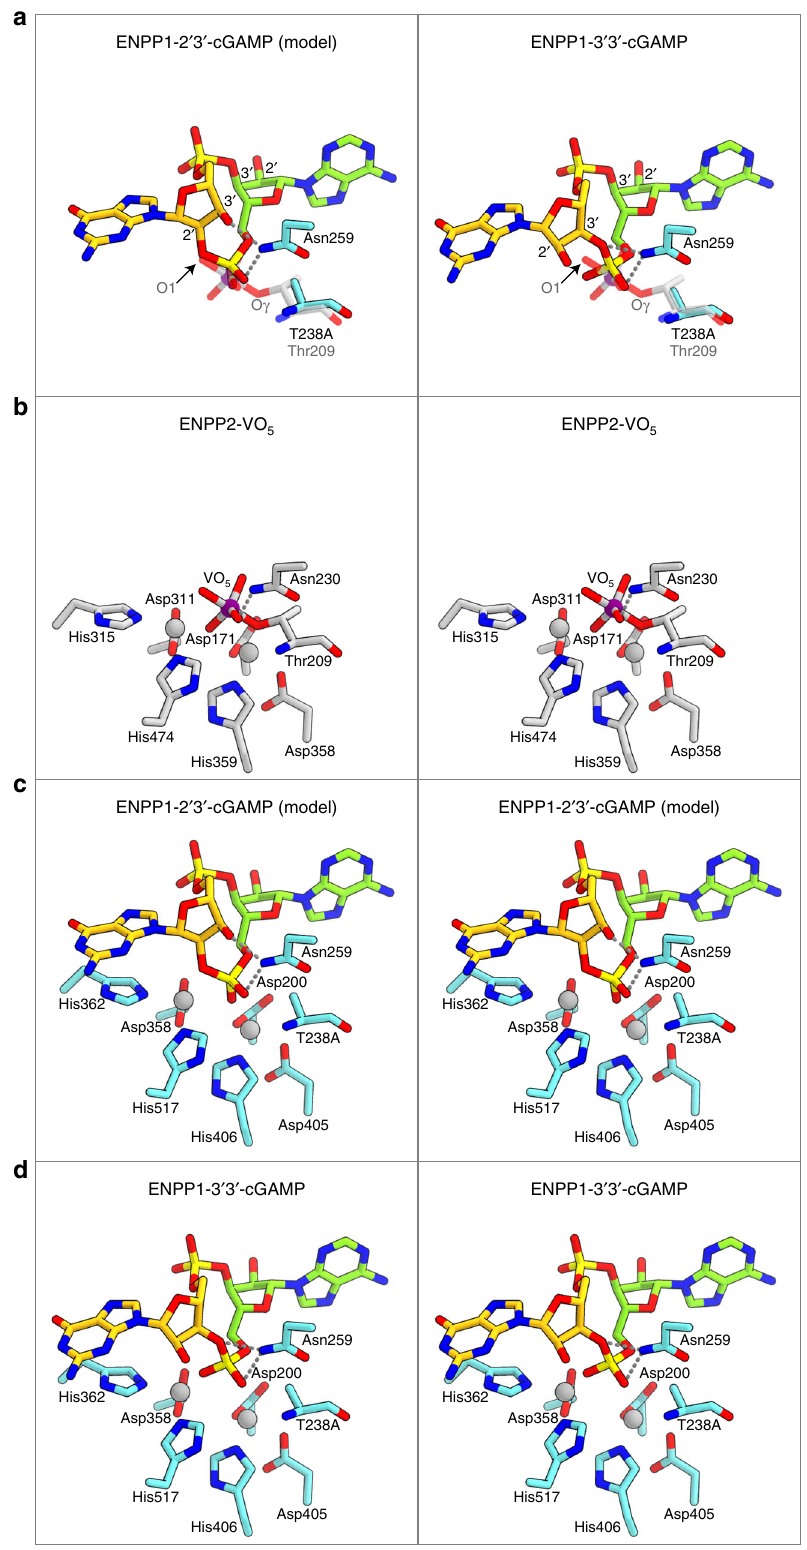
Fig. 4 Structural comparison between the ENPP1-bound 2 ′ 3 ′ -cGAMP and 3 ′ 3 ′ -cGAMP. a Structural comparison of the ENPP1-2 ′ 3 ′ -cGAMP complex (model) (left) and the ENPP1-3 ′ 3 ′ -cGAMP complex (right) with the ENPP2-VO 5 complex (PDB 5IJS) (semi-transparent). The vanadium atom is shown as a purple sphere. Hydrogen bonds are shown as dashed lines. b – d Catalytic centers of the ENPP2-VO 5 complex (PDB 5IJS) ( b ), the ENPP1-2 ′ 3 ′ -cGAMP complex (model) ( c ), and the ENPP1-2 ′ 3 ′ -cGAMP complex ( d ) (stereo views). The zinc and vanadium atoms are shown as gray and purple spheres, respectively. Hydrogen bonds are shown as dashed